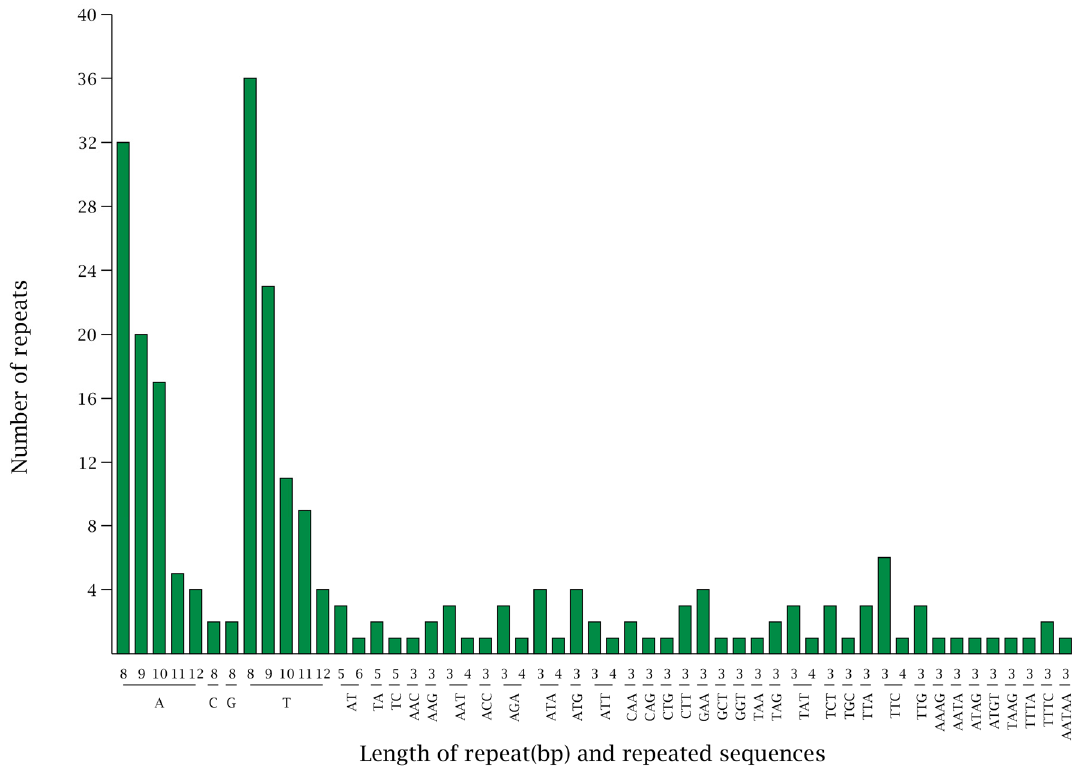
Figure 4. The repeat evaluation and frequency distribution of several SSR types in wild pomegranate.